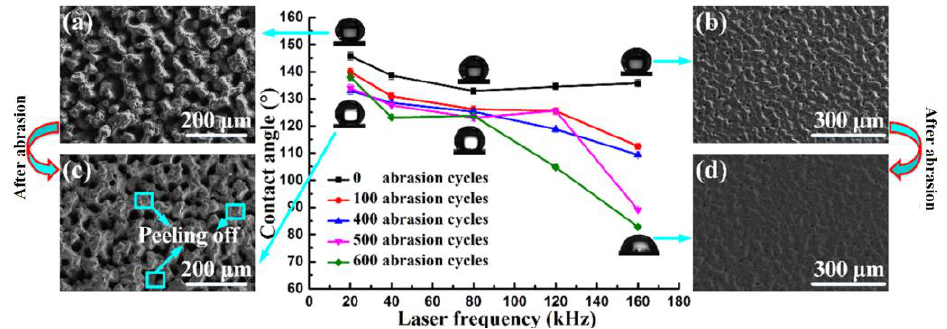
Figure 6. The influence of laser frequency on wettability (SEM images) [16]; ( a ) the hydrophobic surface fabricated at 20 kHz before abrasion; ( b ) the hydrophobic surface fabricated at 160 kHz before abrasion; ( c ) the hydrophobic surface fabricated at 20 kHz after 600 abrasion cycles; ( d ) the hydrophobic surface fabricated at 160 kHz after 600 abrasion cycles.